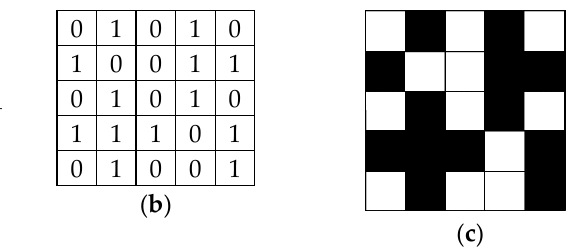
Figure 1. Example of mapping topology optimization into a string. ( a ) Sting of the bit-array, ( b ) bit-array representation, and ( c ) topology design.